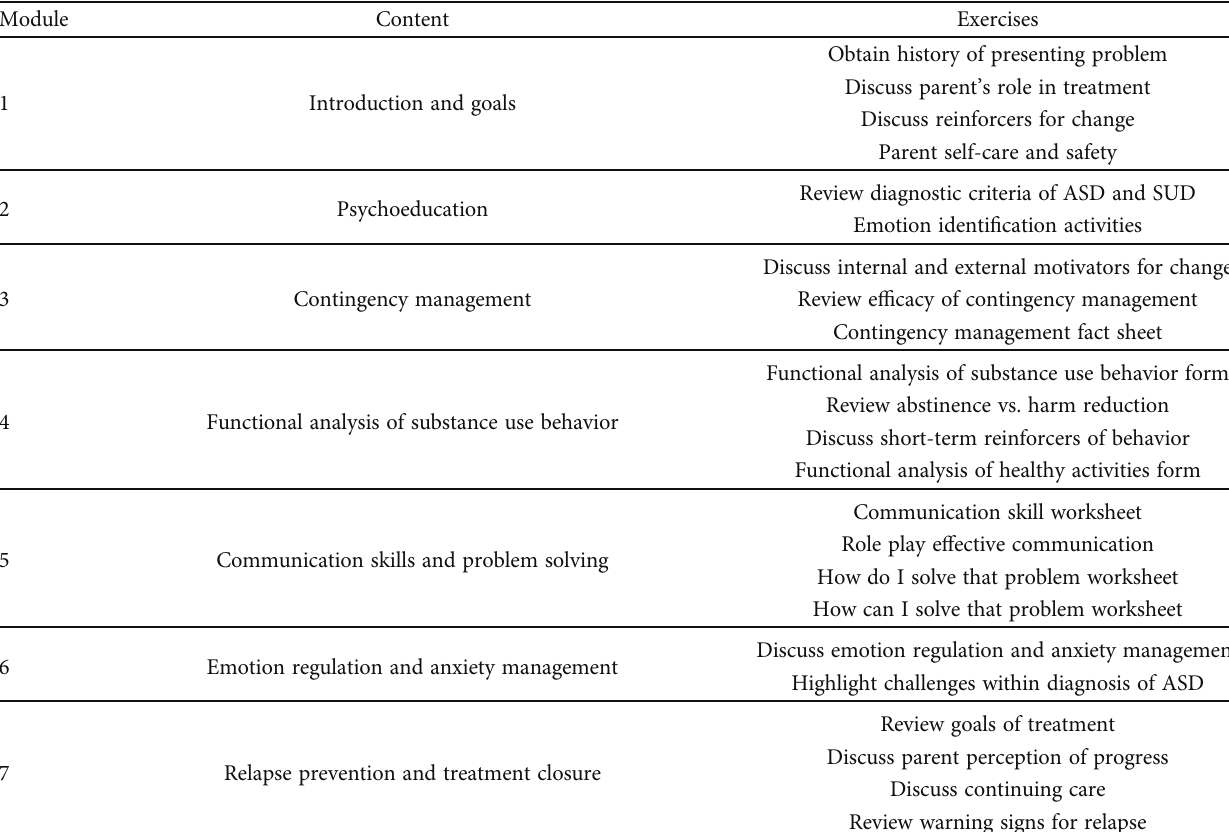
Table 2: Protocol content of parent modules for parents of youth with autism spectrum disorder (ASD) and substance use disorder (SUD). Module